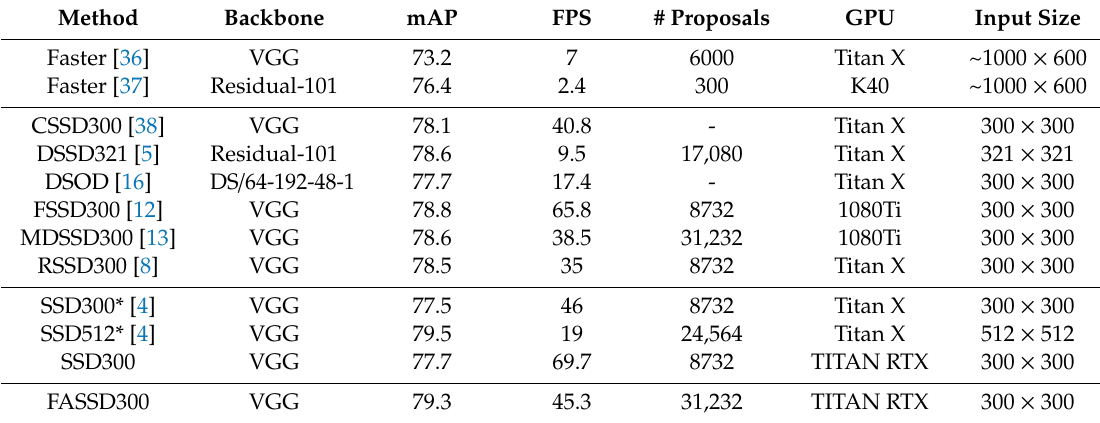
Table 5. Comparison of speed and accuracy on the PASCAL VOC2007 test.